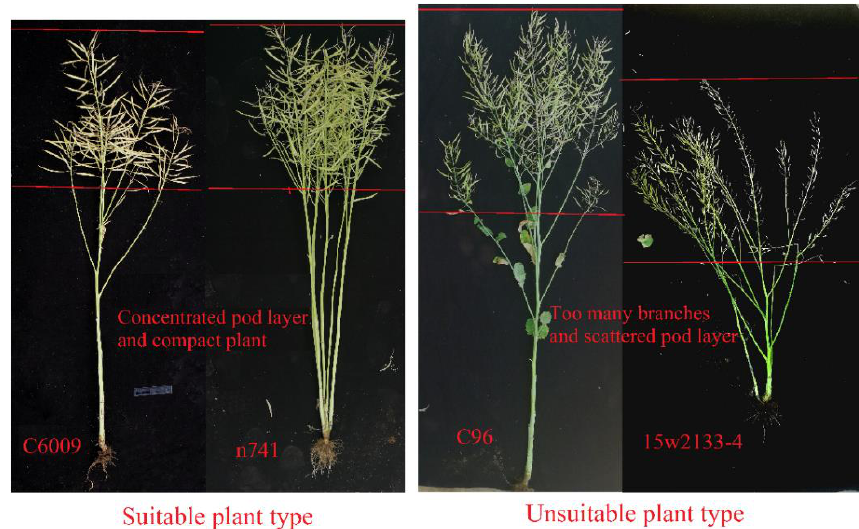
Figure 5. Comparison of rape plant types and features suitable and unsuitable for mechanized harvesting.